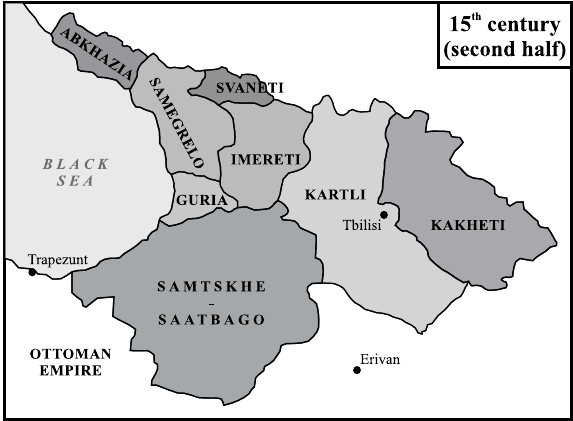
Fig. 3. Stage 3: Feudal